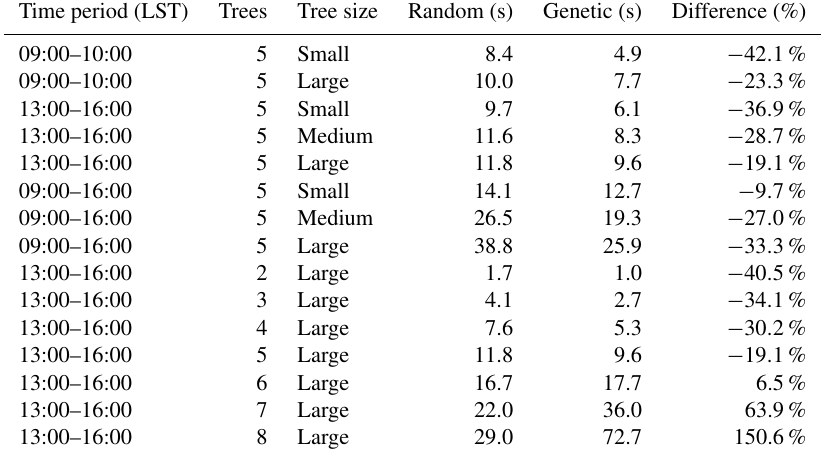
Figure 6. Mean T mrt for 13:00–16:00LST on 22 June 1983, with locations of (a) four large trees and (c) six large trees in green (see Table 1 for detailed tree sizes). Panels (b) and (d) show corresponding differences in T mrt between tree shade and sunlit areas for panels (a) and (c) . The positions are determined with the genetic starting algorithm and 20000 iterations. Table 2. Table showing mean model runtime (s) for 100 iterations for two starting algorithms (random and genetic) with different time periods, number of trees and tree sizes. The difference in model runtime (%) corresponds to a change in model runtime with the genetic starting algorithm compared to the random algorithm. A negative (positive) value corresponds to a decrease (increase) in model runtime with the genetic starting